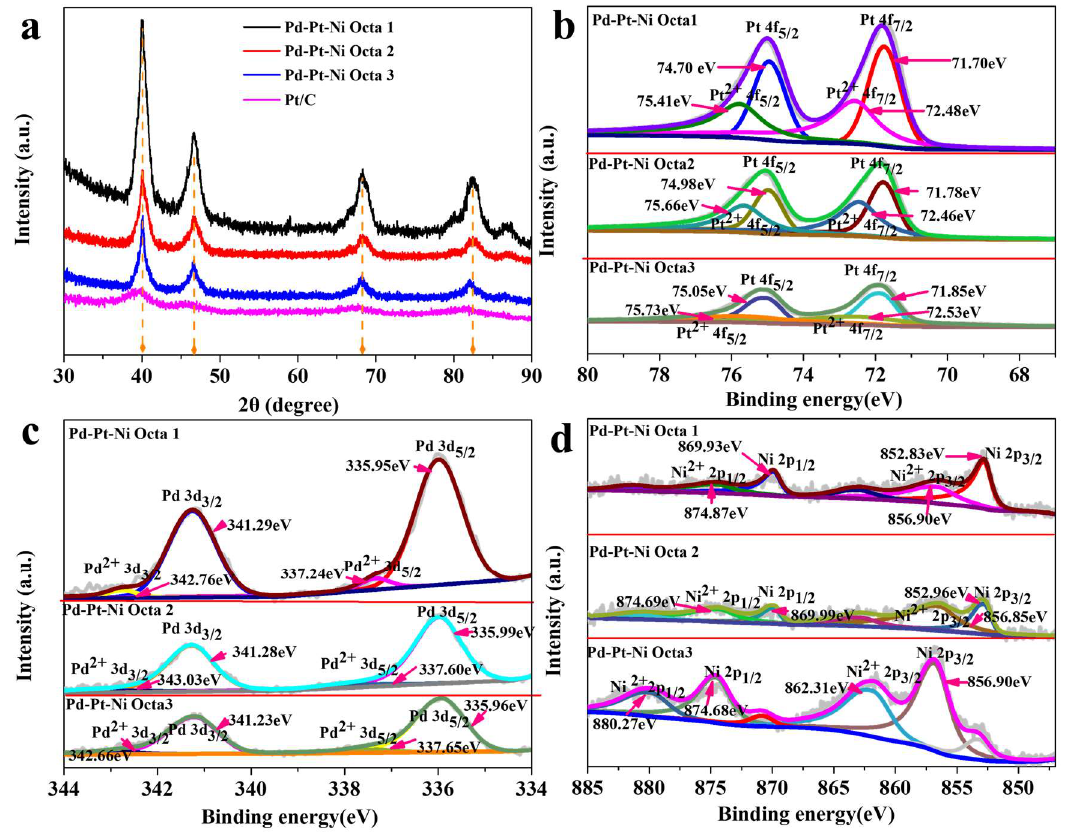
Figure 5. ( a – d ) XRD and XPS patterns of octahedra obtained by different Ni concentration ratios: ( a ) XRD patterns;. ( b ) Pt 4f spectra of Pd-Pt-Ni Octa1, Pd-Pt-Ni Octa2, and Pd-Pt-Ni Octa3; ( c ) Pd 3d spectra of Pd-Pt-Ni Octa1, Pd-Pt-Ni Octa2, and Pd-Pt-Ni Octa3; ( d ) Ni 2p spectra of Pd-Pt-Ni Octa1, Pd-Pt-Ni Octa2, and Pd-Pt-Ni Octa3.